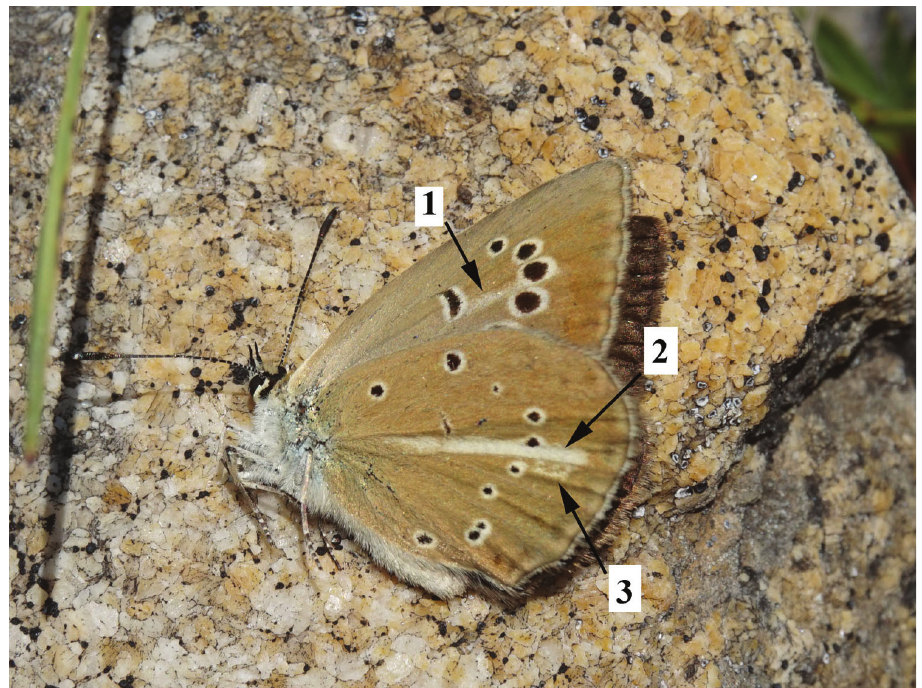
Figure 12. Polyommatus orphicus orphicus collected in the type locality (Bulgaria, Hvoyna, 3 July 2016). Photo by E. Pazhenkova. White postdiscal streak between discal spot and submarginal marking on the forewing underside (character 1), prominent white streak on the hindwing underside (character 2) and additional white short streak between postdiscal and submarginal areas of the hind wing underside (char- acter 3) are